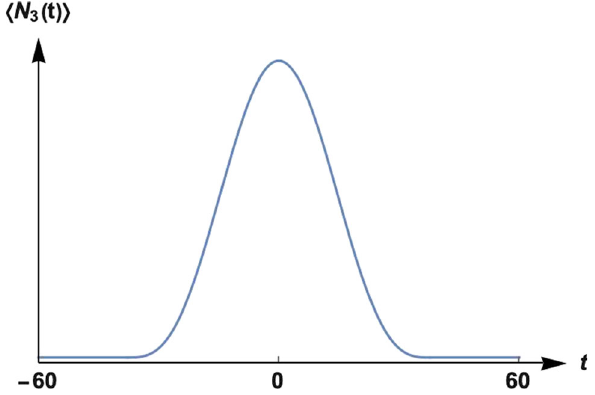
Fig. 2 Schematicillustrationofthevolumeprofile (cid:2) N 3 ( t ) (cid:3) ofthequan- tum spacetime in the de Sitter phase, consisting of a spatially extended universe (here centred around t = 0) and a stalk of minimal spatial